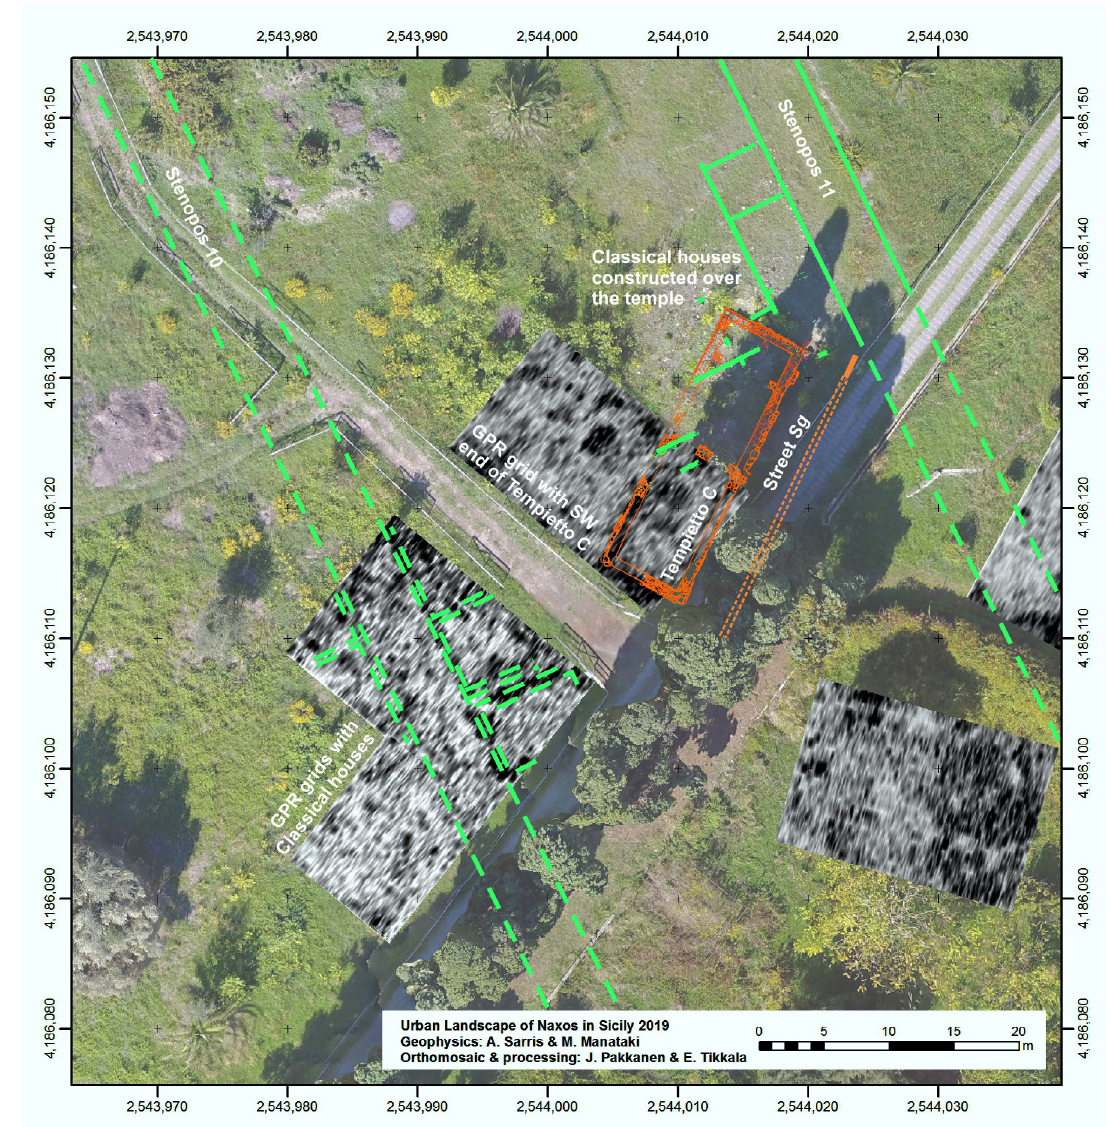
Figure 2. Area of Tempietto C. Excavated remains (solid lines), reconstructed features (dashed lines) and GPR grids superimpo- sed on the aerial orthomosaic. Orange = Early Archaic; light green = Classical (Jari Pakkanen, Esko Tikkala, Apostolos Sarris, & Meropi